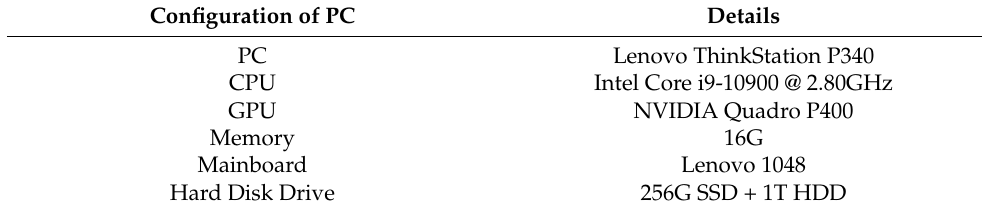
Table 2. Hardware configuration